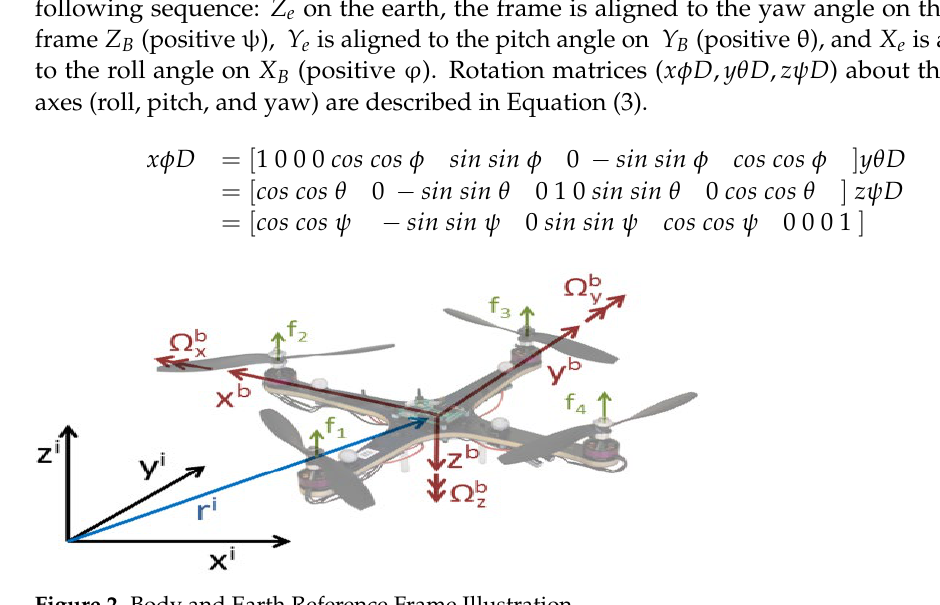
Figure 2. Body and Earth Reference Frame Illustration.